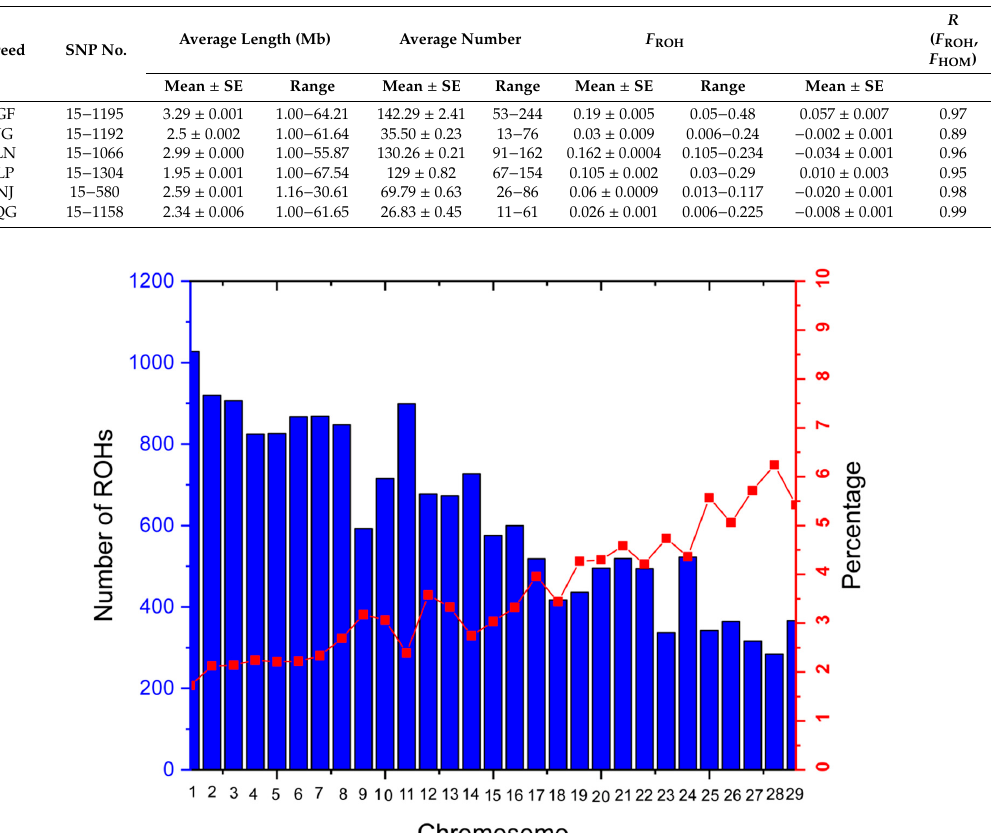
Figure 2. Number of runs of homozygosity (ROHs) per chromosome identified in 204 goat breeds that had at least one ROH (bars), and the percentage of each chromosome covered by ROHs